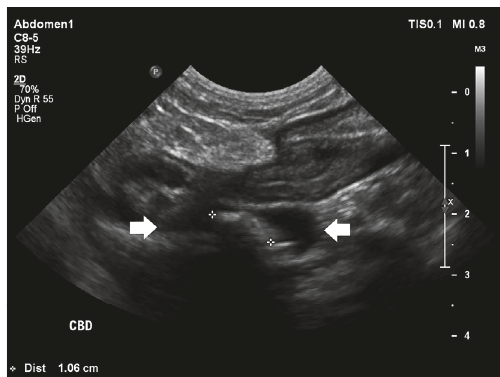
Figure 2: Abdominal ultrasonography. Note the 1.06 cm choledo- cholith (white crosshairs) obstructing the entrance of the common bileductintotheduodenumresultinginmarkedbileductdistension (white